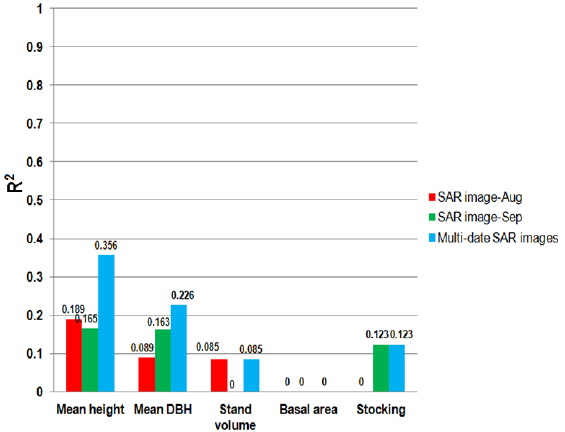
Figure 2. The R 2 results of SAR images individually and